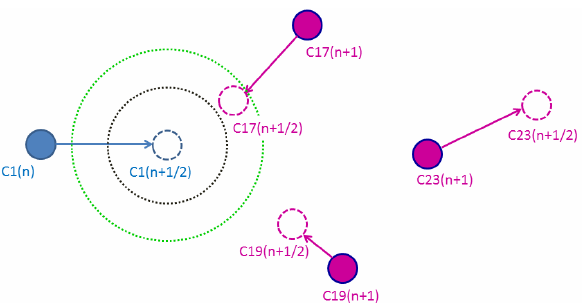
Fig. A3. Schematic illustration of the storm-track construction procedure. Beginning with Clump 1 at time n (blue circle) the average steering velocity from all Clump 1 grid points is used to estimate the Clump 1 position at time n + 1 / 2 (blue dashed circle). For all clumps at time n + 1 (purple circles), the average steering velocities are reversed to estimate their positions at time n + 1 / 2 (purple dashed circles). A search is extended outwards from the estimated half-way position of Clump 1, in 100km radius increments, for a potential match with an n + 1 clump. The first search (black dotted circle) finds no match. The second search (green dotted circle) finds a match with Clump 17. Clump 1 and 17 are considered to be the same circulation separated by one unit of time.